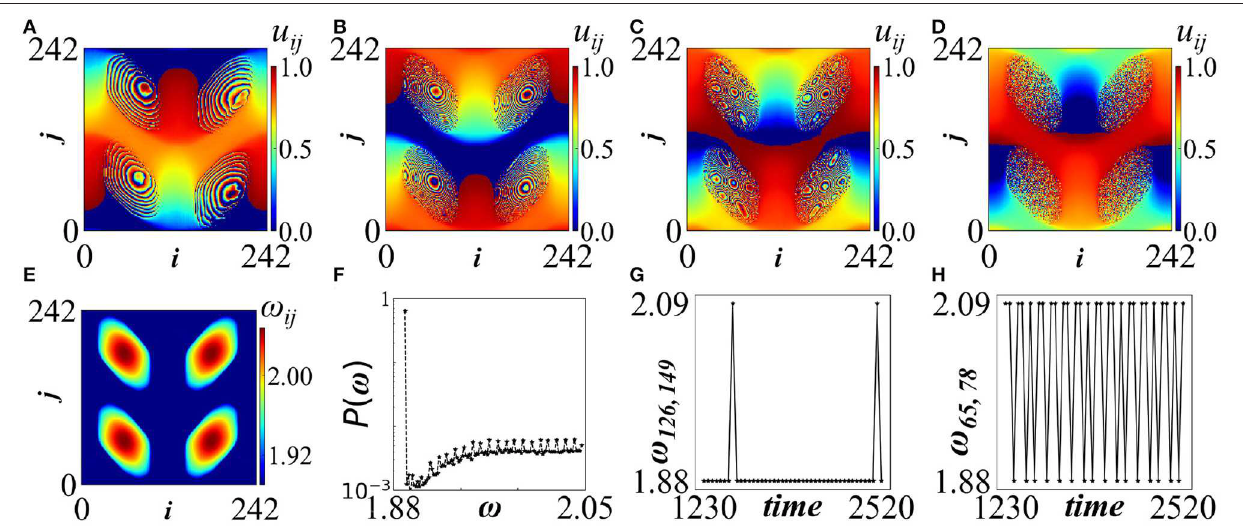
FIGURE 4 | Top row: Spiral wave multichimera state with four incoherent cores in symmetric deterministic connectivity for system size 243 × 243; the potential profiles are depicted at times: (A) t = 1200, (B) t = 1800 (C) t = 2700 and (D) t = 10020 time units. Bottom row: (E) Mean phase velocity profile, (F) Typical histogram of mean phase velocities, (G) Time evolution of ω on a node contained in the coherent regions and (H) Time evolution of ω on a node belonging to one of the incoherent cores. Parameters are σ = 0.25 and T r = 0.5 and N = 243. All other parameters are as in Figure 2A . Simulations start from random initial conditions. A related video is included in the Supplementary Material .